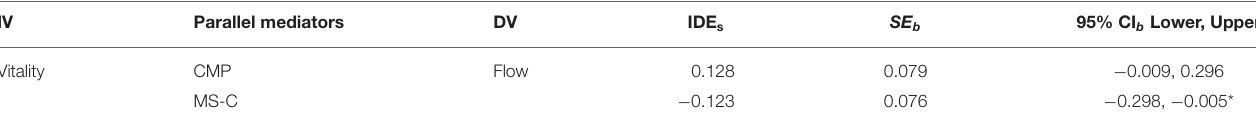
TABLE 5 | Indirect effects of subjective vitality on dispositional flow through movement-specific reinvestment dimensions ( n =